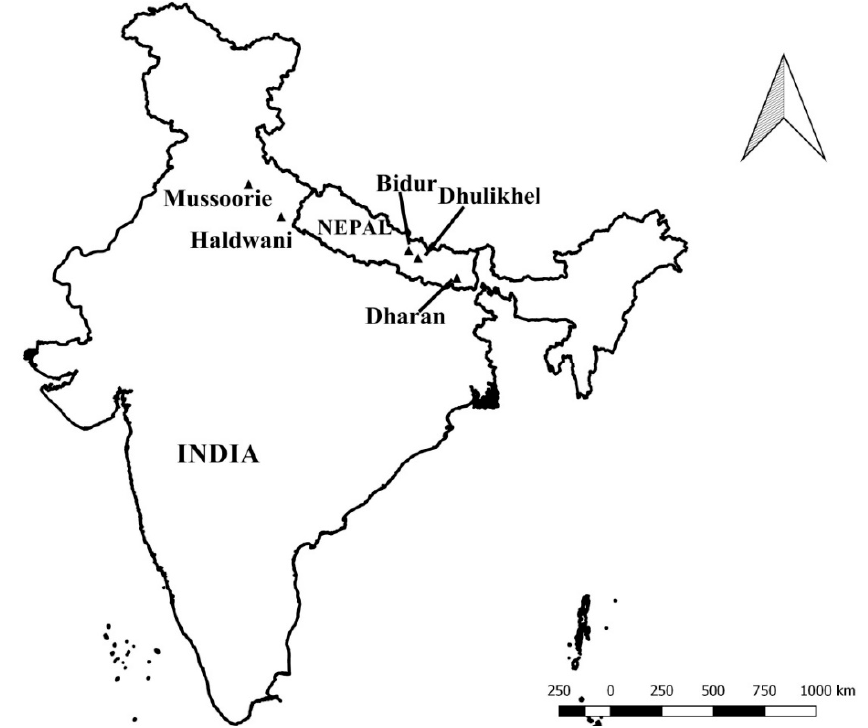
Figure 2. Location of the five case study cities in the Himalayas.